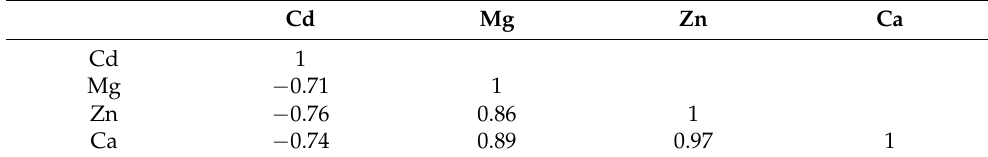
Table 3. The Pearson correlation matrix of the Zn network elements (on natural log scale). Cd Mg Zn Ca Cd